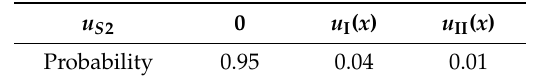
Table 6. Probability values for individual S 2 network configuration